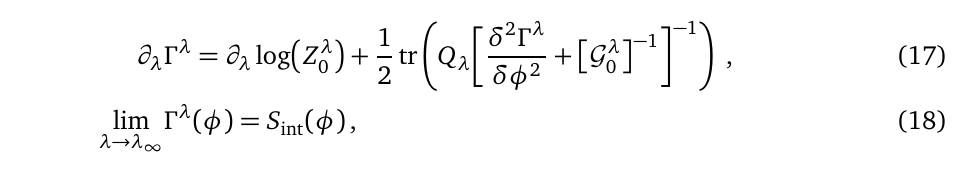
= 3 and dotted lines m = 2 results. c c